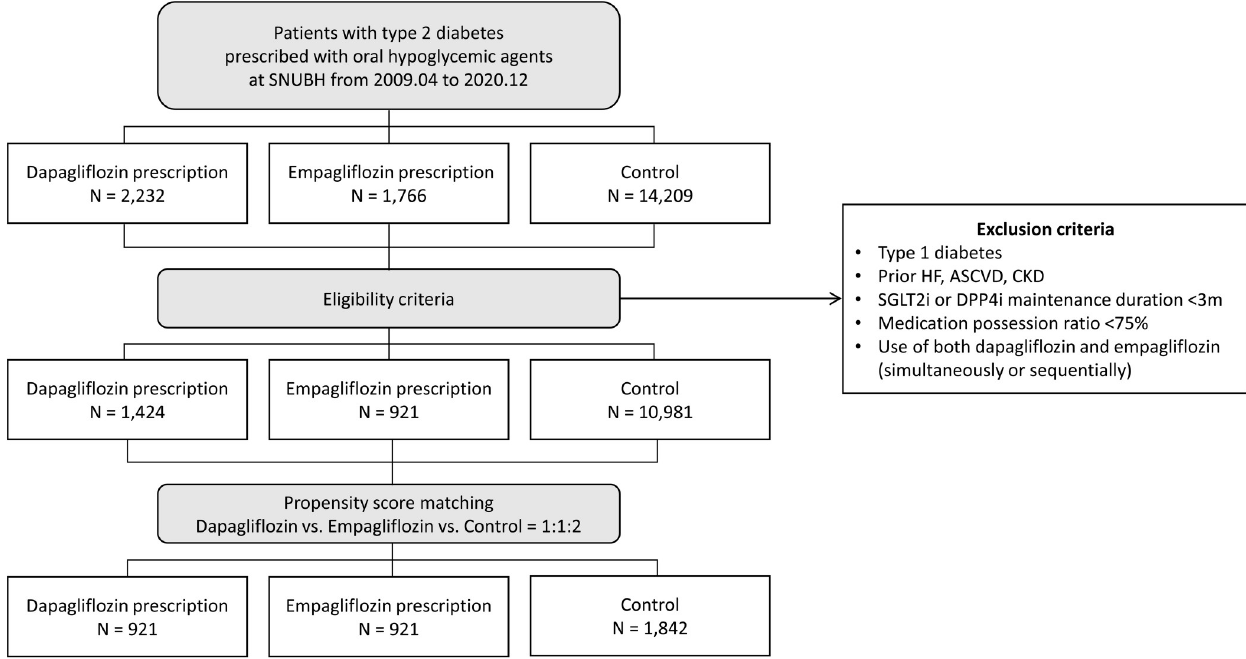
Fig 1. Study flowchart. After 1:1:2 propensity score matching, there were 921 patients treated with empagliflozin, 921 patients treated with dapagliflozin, and 1,842 patients treated with DPP4i (control group). ASCVD, atherosclerotic cardiovascular disease; CKD, chronic kidney disease; DPP4i, dipeptidyl peptidase-4 inhibitor; HF, heart failure; SGLT2i, sodium-glucose co-transporter 2 inhibitor.